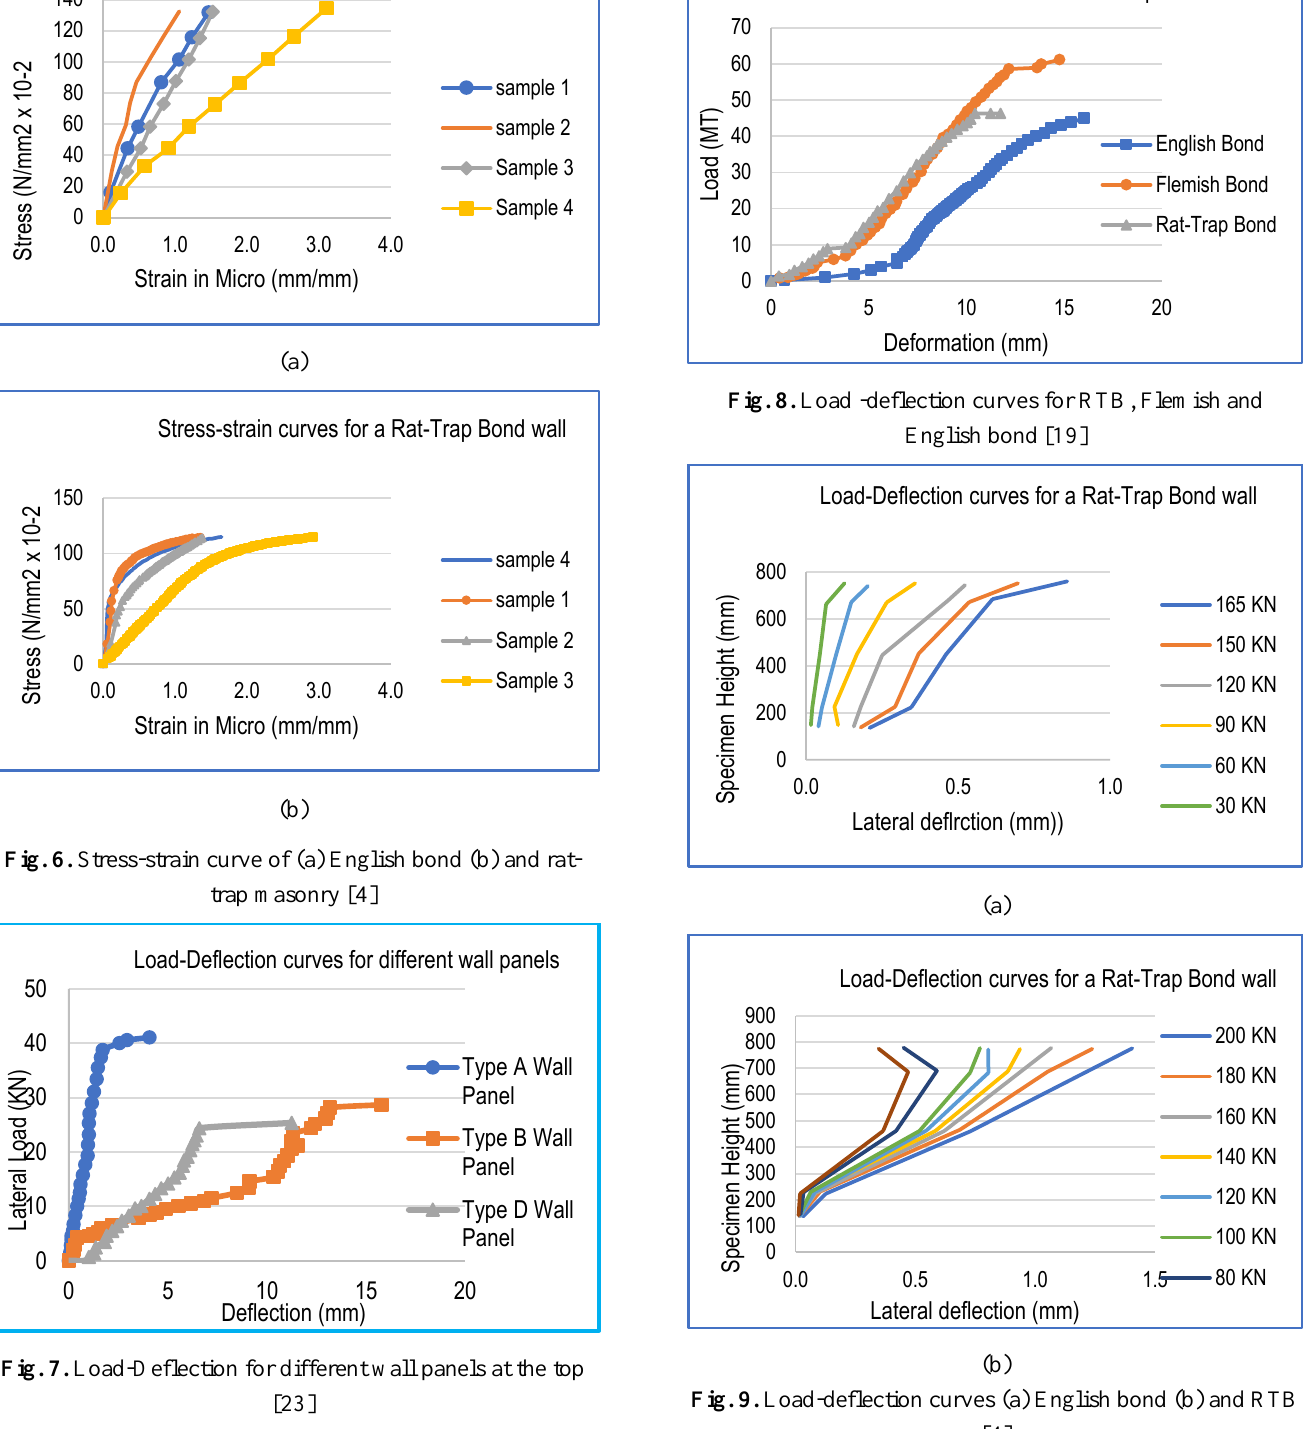
Fig. 9. Load-deflection curves (a) English bond (b) and RTB